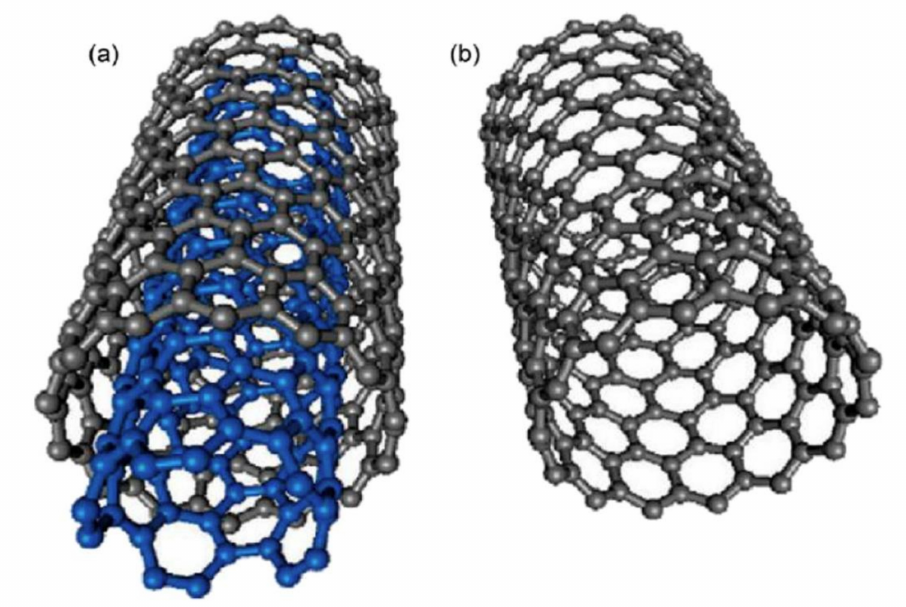
Figure 8. Schematic representation of ( a ) MWCNT and ( b ) SWCNT structures. Reprinted from [161] with permission of